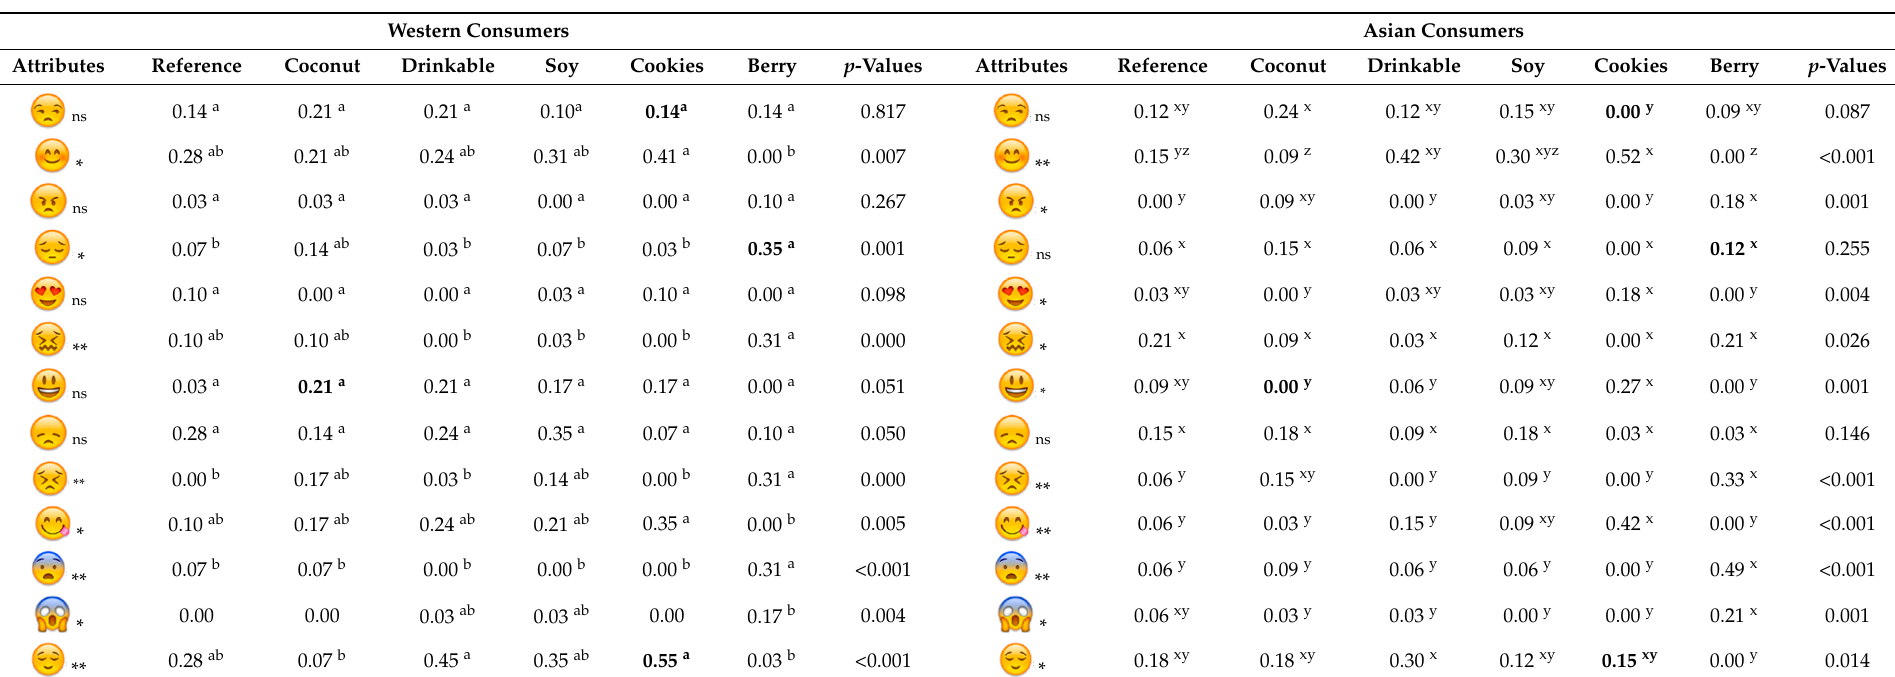
Table 3. Cochran’s Q test for emoji terms shown for the two cultural groups (Western consumers, Asian consumers) comparing terms within the culture, and using Fisher’s test to compare terms across cultures.